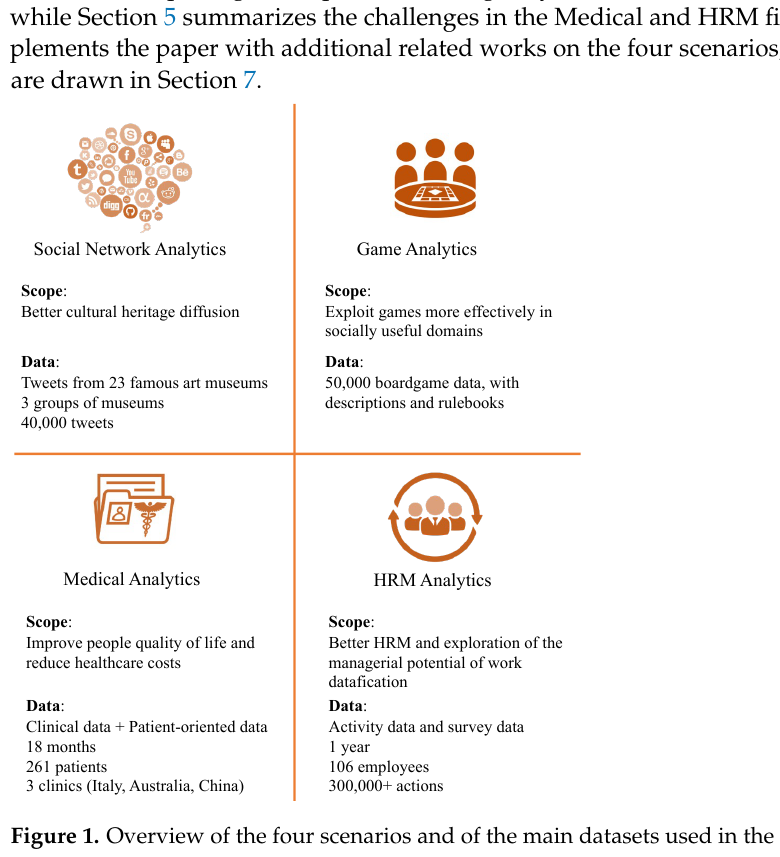
Figure 1. Overview of the four scenarios and of the main datasets used in the